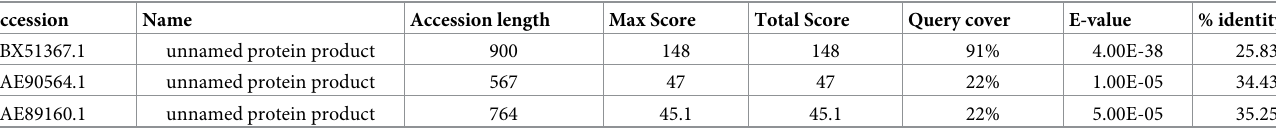
Table 7. BLAST result for the homologues of the target protein in the human